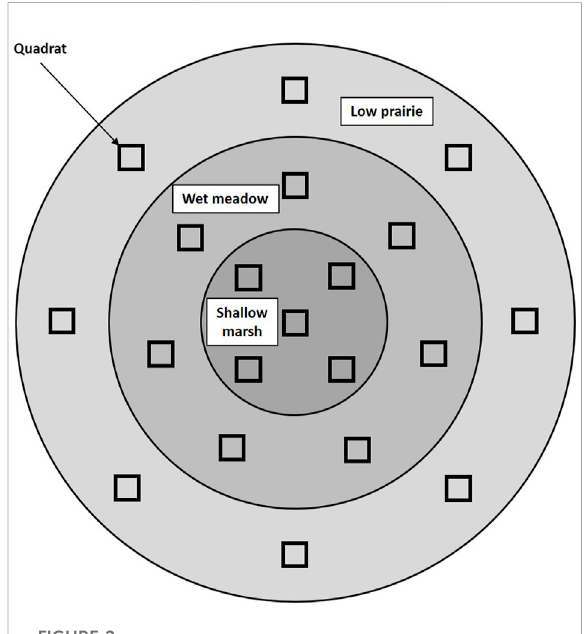
FIGURE 2 General vegetation sample layout for quadrats in the low- prairie, wet-meadow, and shallow-marsh zones of seasonally ponded wetlands of the Prairie Pothole Region of North America (see DeKeyser et al., 2003; Hargiss, 2009). Temporarily ponded wetlands have a similar layout, but only have an exterior low-prairie zone and a central wet-meadow